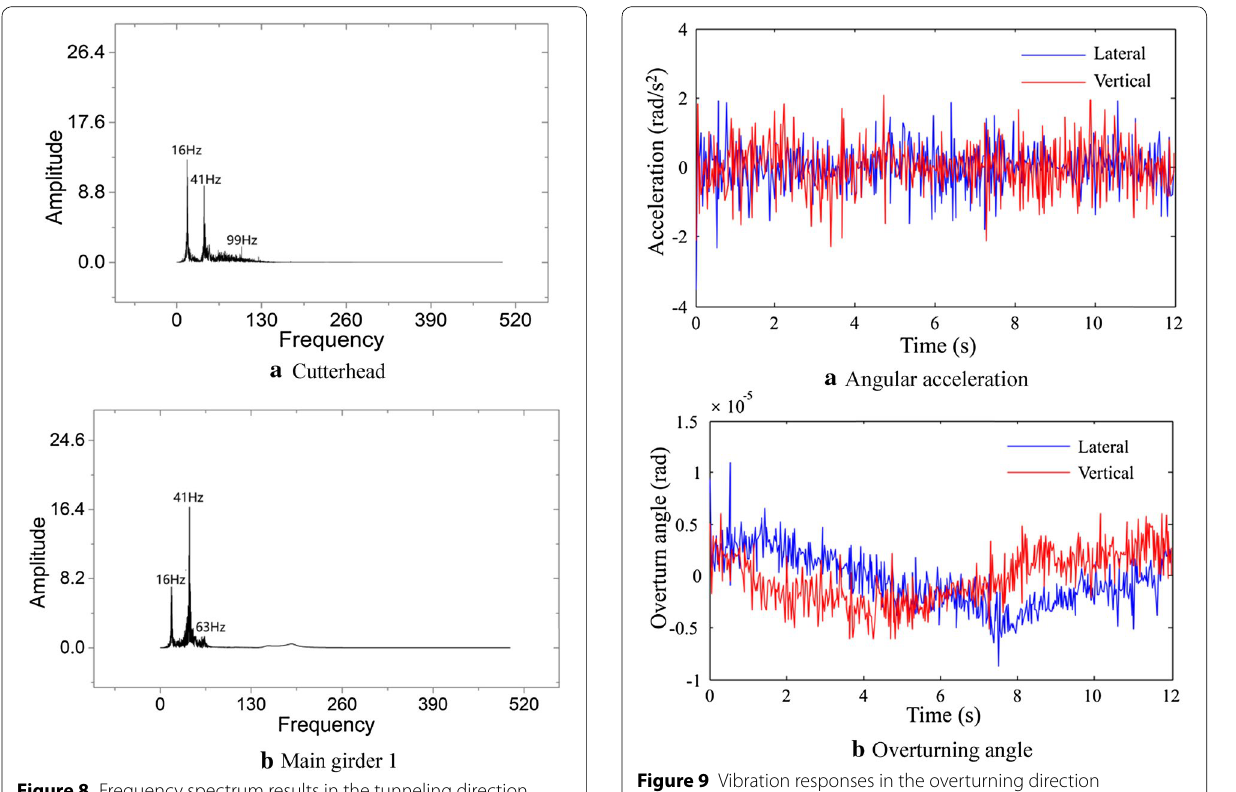
Figure 8 Frequency spectrum results in the tunneling direction